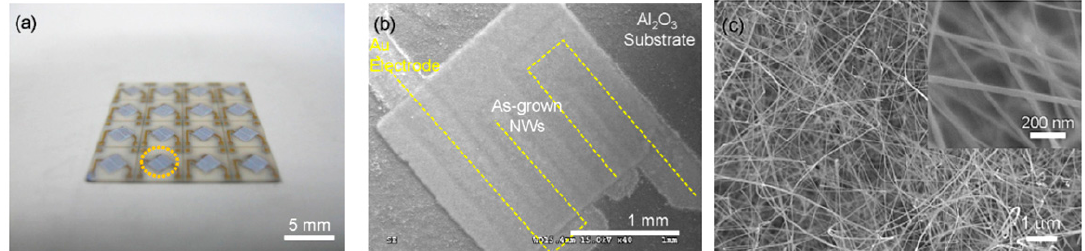
Figure 35. The sensor elements: ( a ) 16 sensor elements prepared by the one-pot growth of SnO 2 nanowire networks on laser-scriber Al 2 O 3 substrates; ( b ) SEM image of one sensor element; ( c ) SEM image of SnO 2 nanowire networks. Reproduced with permission from Hwang et al. [153]. Copyright 2012: Elsevier.